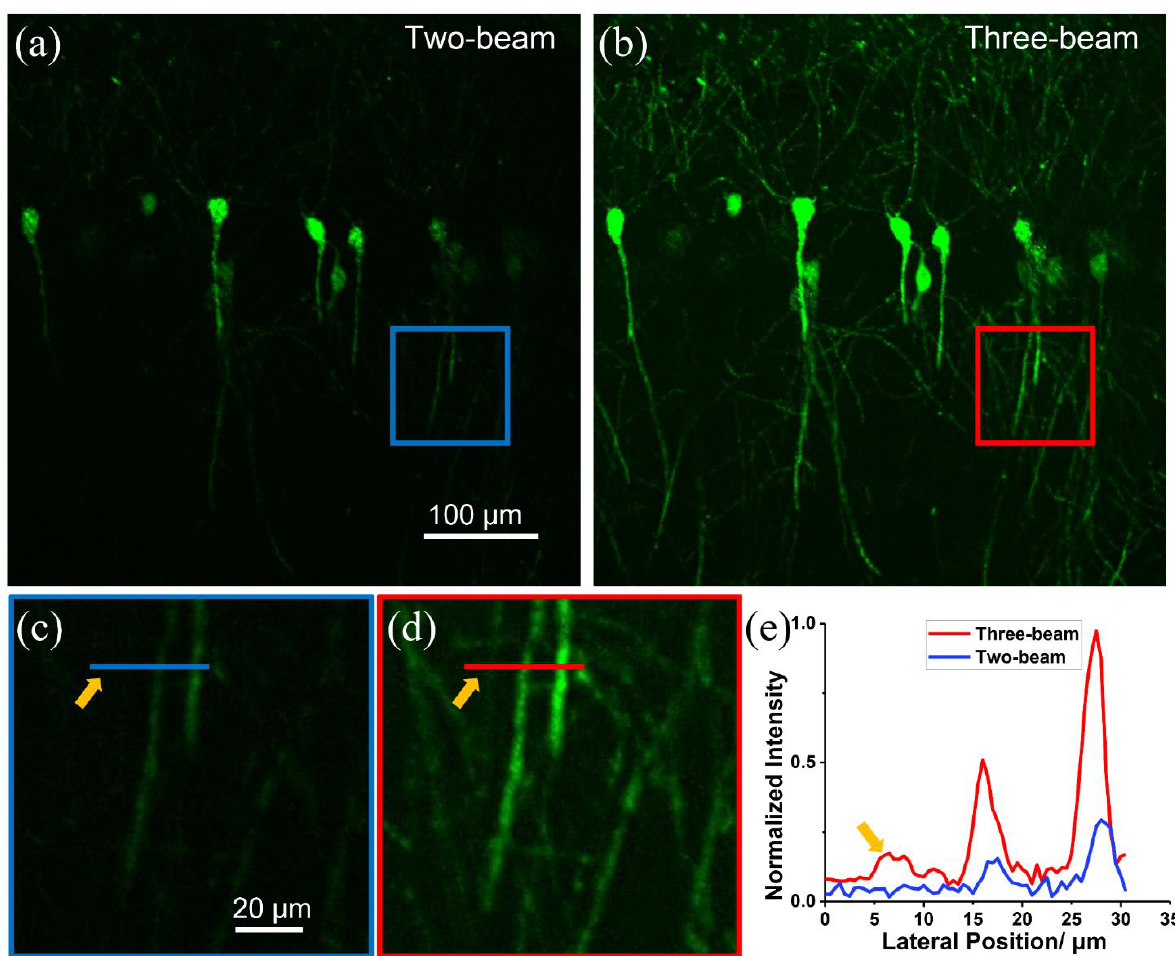
Figure 4. SIM images of brain tissue section acquired by two-beam illumination ( a ) and three-beam illumination ( b ). ( c , d ) Magnification images of the solid rectangles in ( a , b ). ( e ) The cross-sectional intensity profiles along the dendrites indicated by the solid lines in ( c , d ). All images were normalized to the maximum gray value of the two-beam interference SIM image.